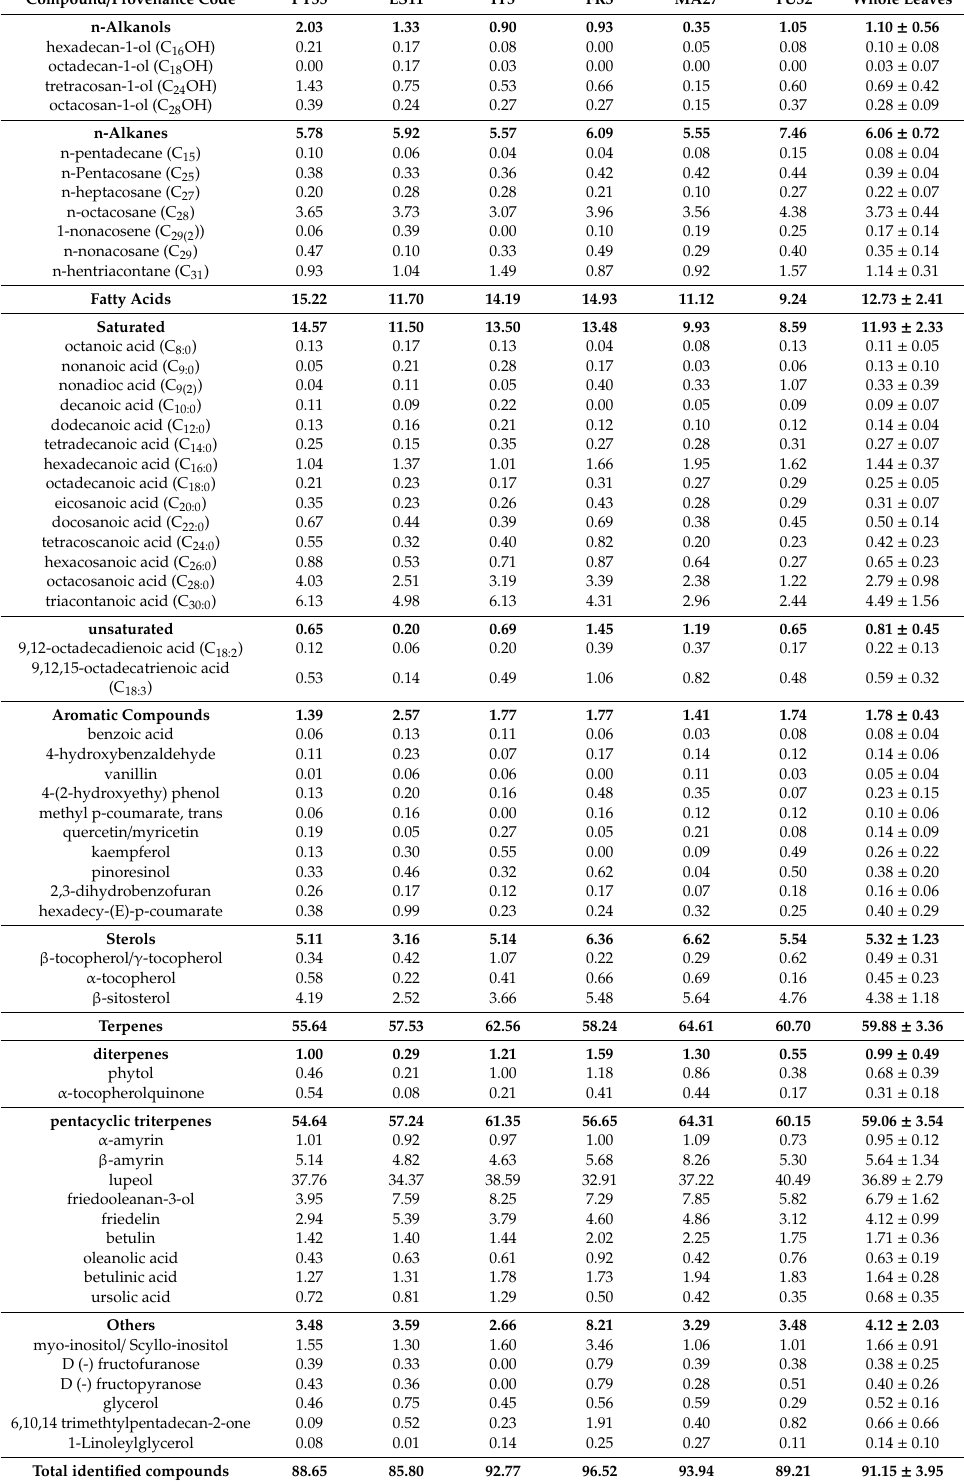
Table 3. Chemical composition (% of all chromatogram peak areas) of the cuticular waxes of leaves from six Quercus suber provenances (mean of two trees per provenance). The provenances are Portugal (PT35), Spain (ES11), Italy (IT3), France (FR3), Morocco (MA27) and Tunisia (TU32). Compound / Provenance